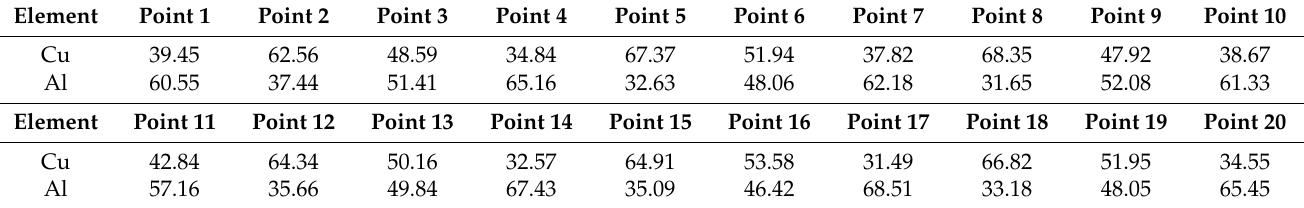
Table 3. The element contents of Cu and Al by element point scanning at point 1–20